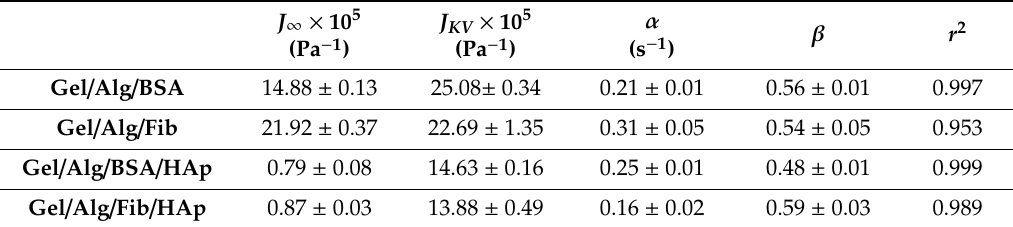
Table 3. Compliance of the Maxwell dashpot, Kevin-Voigt element and parameters obtained from the fitting by Equation